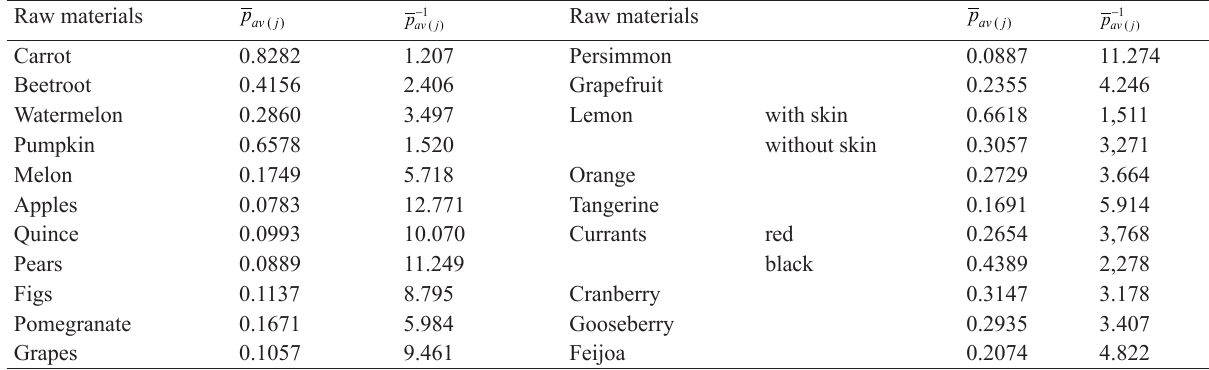
Table 2 Weighted average reduced measures of raw materials value in non-uronide biologically active components Raw materials